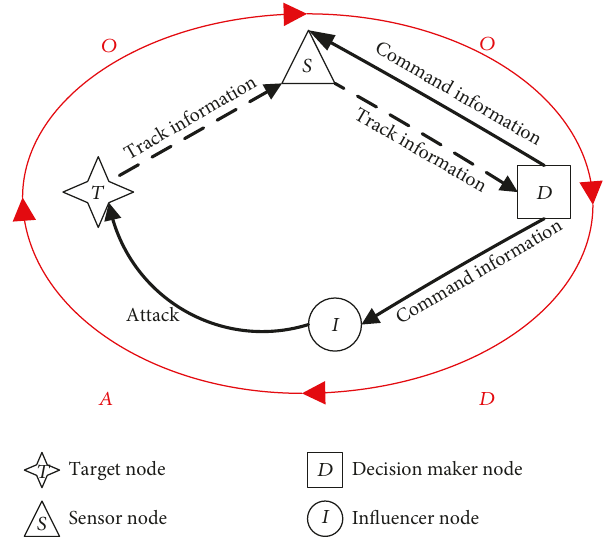
Figure 1: Network